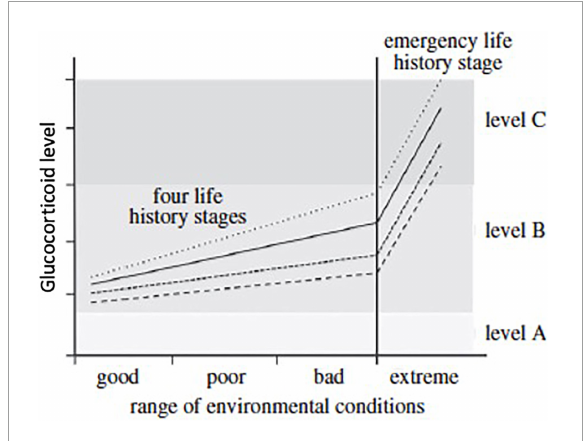
FIGURE6 The hypothetical relationships of circulating glucocorticoids and the range of environmental conditions expected when a specific life-history stage is expressed (strategy 2, Figure 5 ). Environmental conditions can be expected to be good, poor or bad for each life-history stage. Baseline glucocorticoid levels in blood tend to increase slowly as conditions deteriorate and increase allostatic load. These concentrations rise above level A (homeostatic level, lightest shade of gray) and within level B (reactive scope for that life-history stage, middle shade of gray). When conditions become extreme (right hand vertical line) then glucocorticoid levels increase rapidly to level C as a result of allostatic overload; that then triggers facultative responses such as the emergency life-history stage (darkest shade of gray). The slope of the lines for circulating corticosteroids will vary among life-history stages. Four are presented here with one showing low baseline and rate of increase as well as maximum level. Such variation in the dynamics of glucocorticoid responses to deteriorating weather events and stress in general are common. From Wingfield et al. (2017) courtesy of the Royal Society.